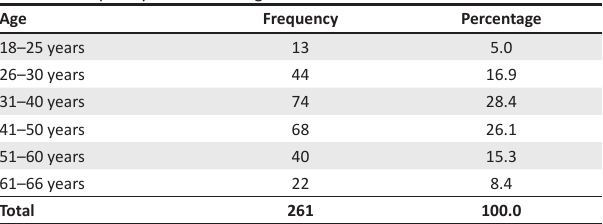
TABLE 3: Frequency table of the age.